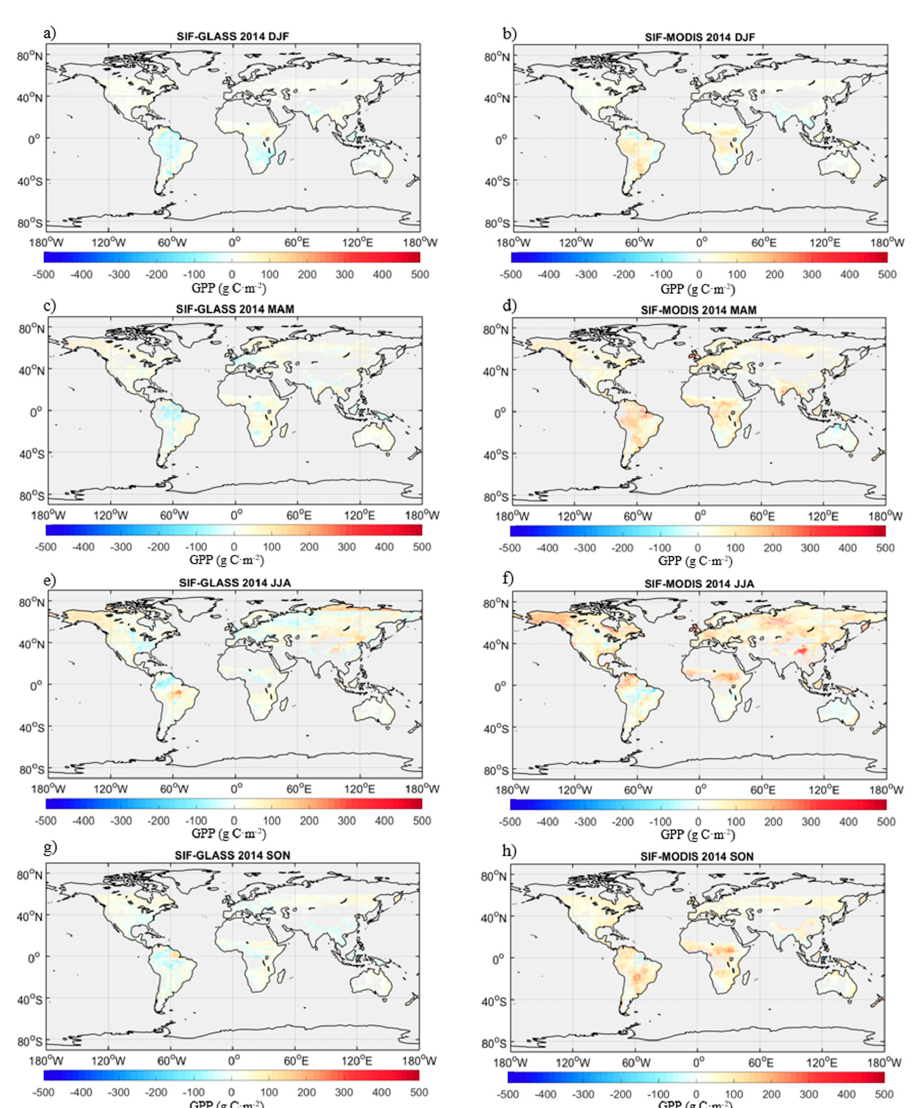
Figure 5. Differences in spatial patterns of global GPP in different seasons in 2014: ( a ) difference between GPP SIF and GPP GLASS in DJF; ( b ) difference between GPP SIF and GPP MODIS in DJF; ( c ) difference between GPP SIF and GPP GLASS in MAM; ( d ) difference between GPP SIF and GPP MODIS in MAM; ( e ) difference between GPP SIF and GPP GLASS in JJA; ( f ) difference between GPP SIF and GPP MODIS in JJA; ( g ) difference between GPP SIF and GPP GLASS in SON; ( h ) difference between GPP SIF and GPP MODIS in SON.